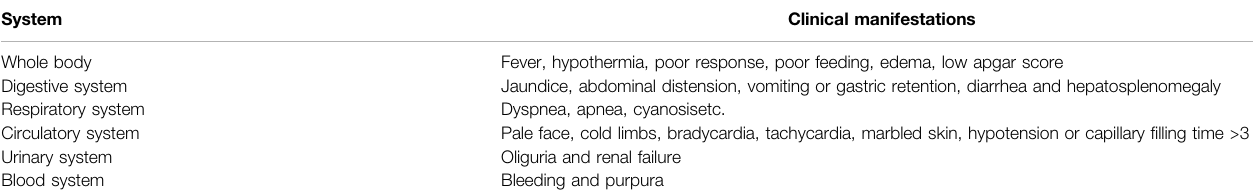
TABLE 2 | Clinical manifestations of neonatal